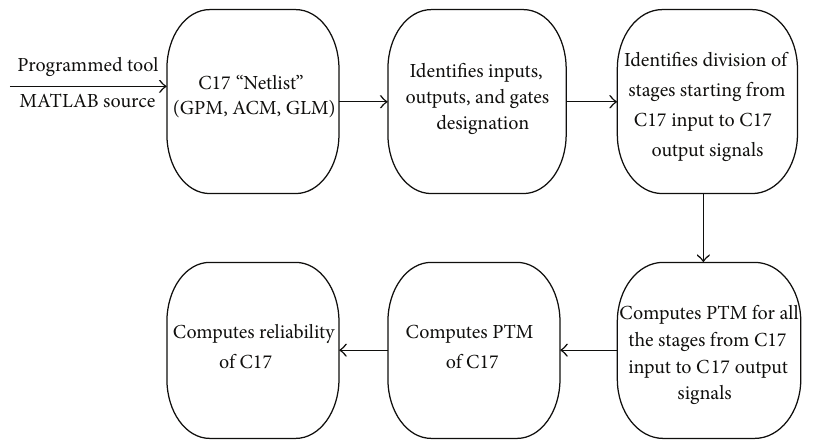
Figure 7: How automated tool generates PTM and reliability of